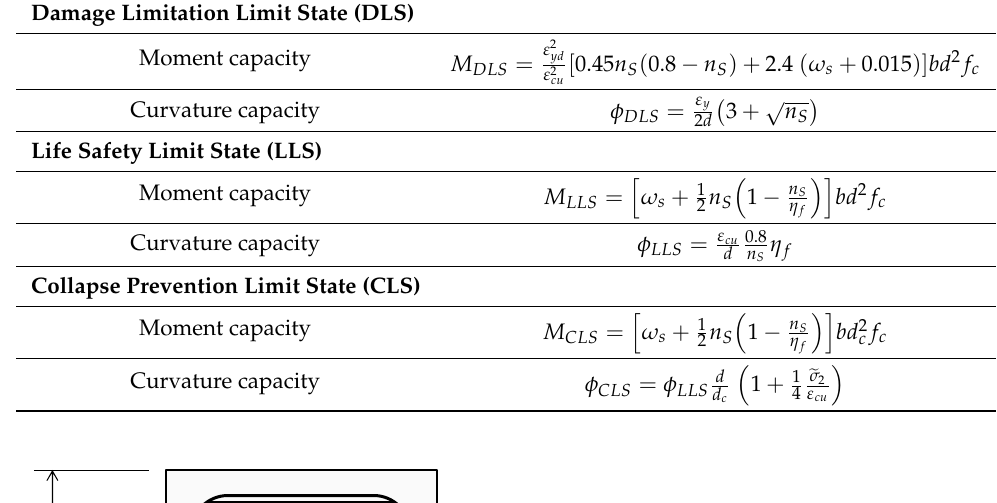
Figure 1. Cross-section with geometric parameters. Table 1. Flexural failure: equations for resisting moment and curvature at three LSs for the case of rectangular sections with symmetric reinforcement.